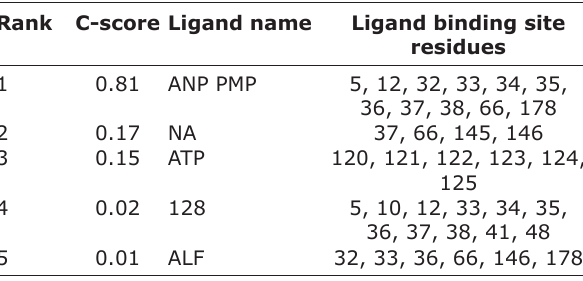
Table-3: The ligand name prediction and residual binding sites of the T. evansi MRPE protein.